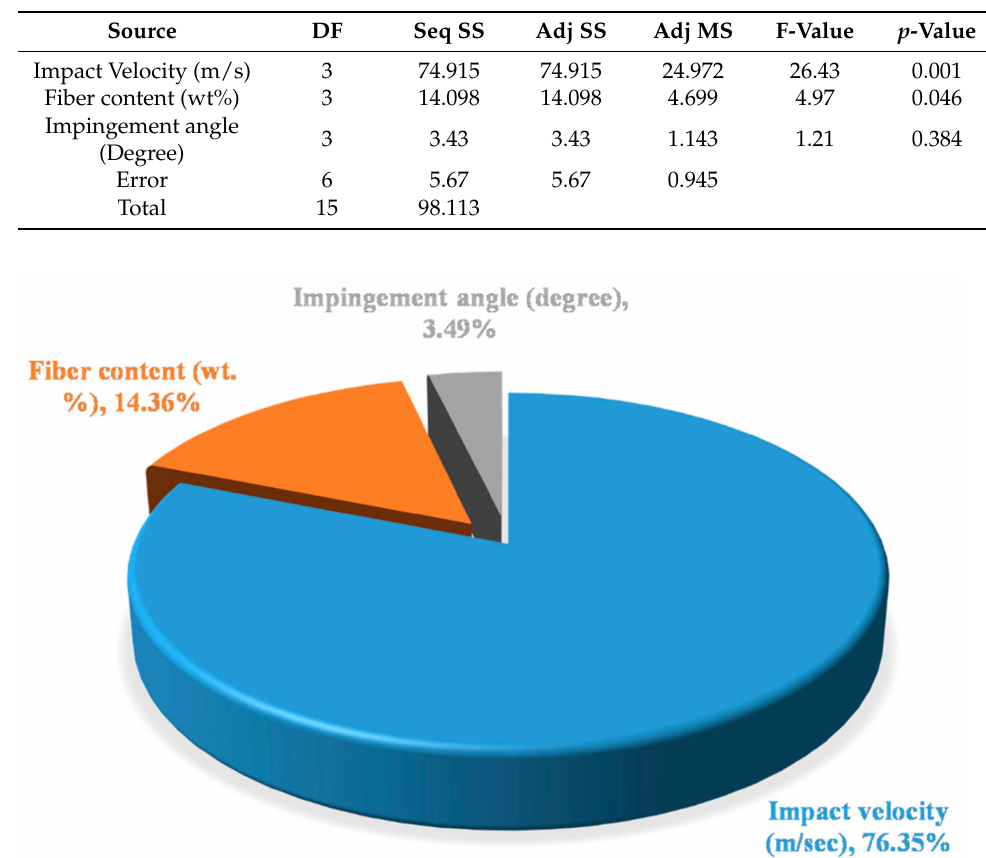
Figure 7. Contribution chart of factors for epoxy-based composites. The p -value of control factors or vinyl ester-based composites is shown in Table 9.